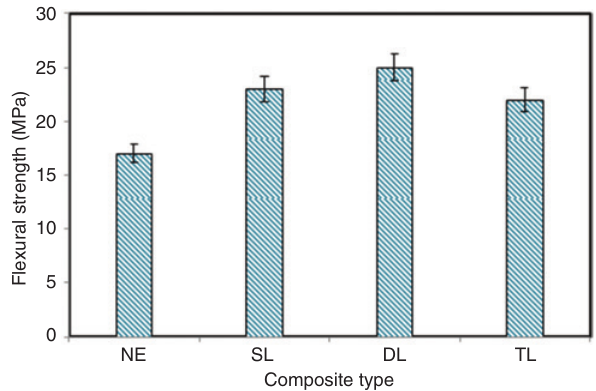
Figure 3: Flexural strength of single-, double-, and triple-layer untreated LCF epoxy composites.